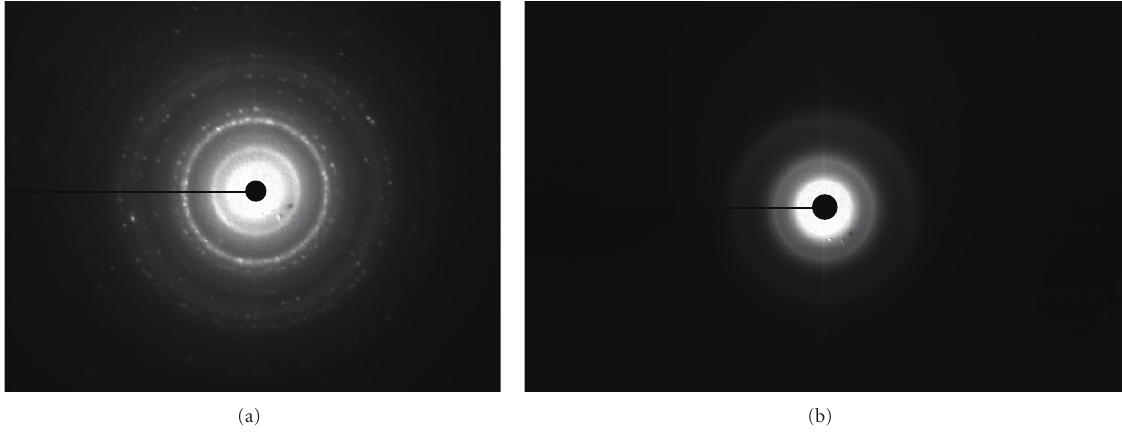
Figure 7: Selected area di ff raction pattern (SAED) of (a) MN-1, and (b) MN-5